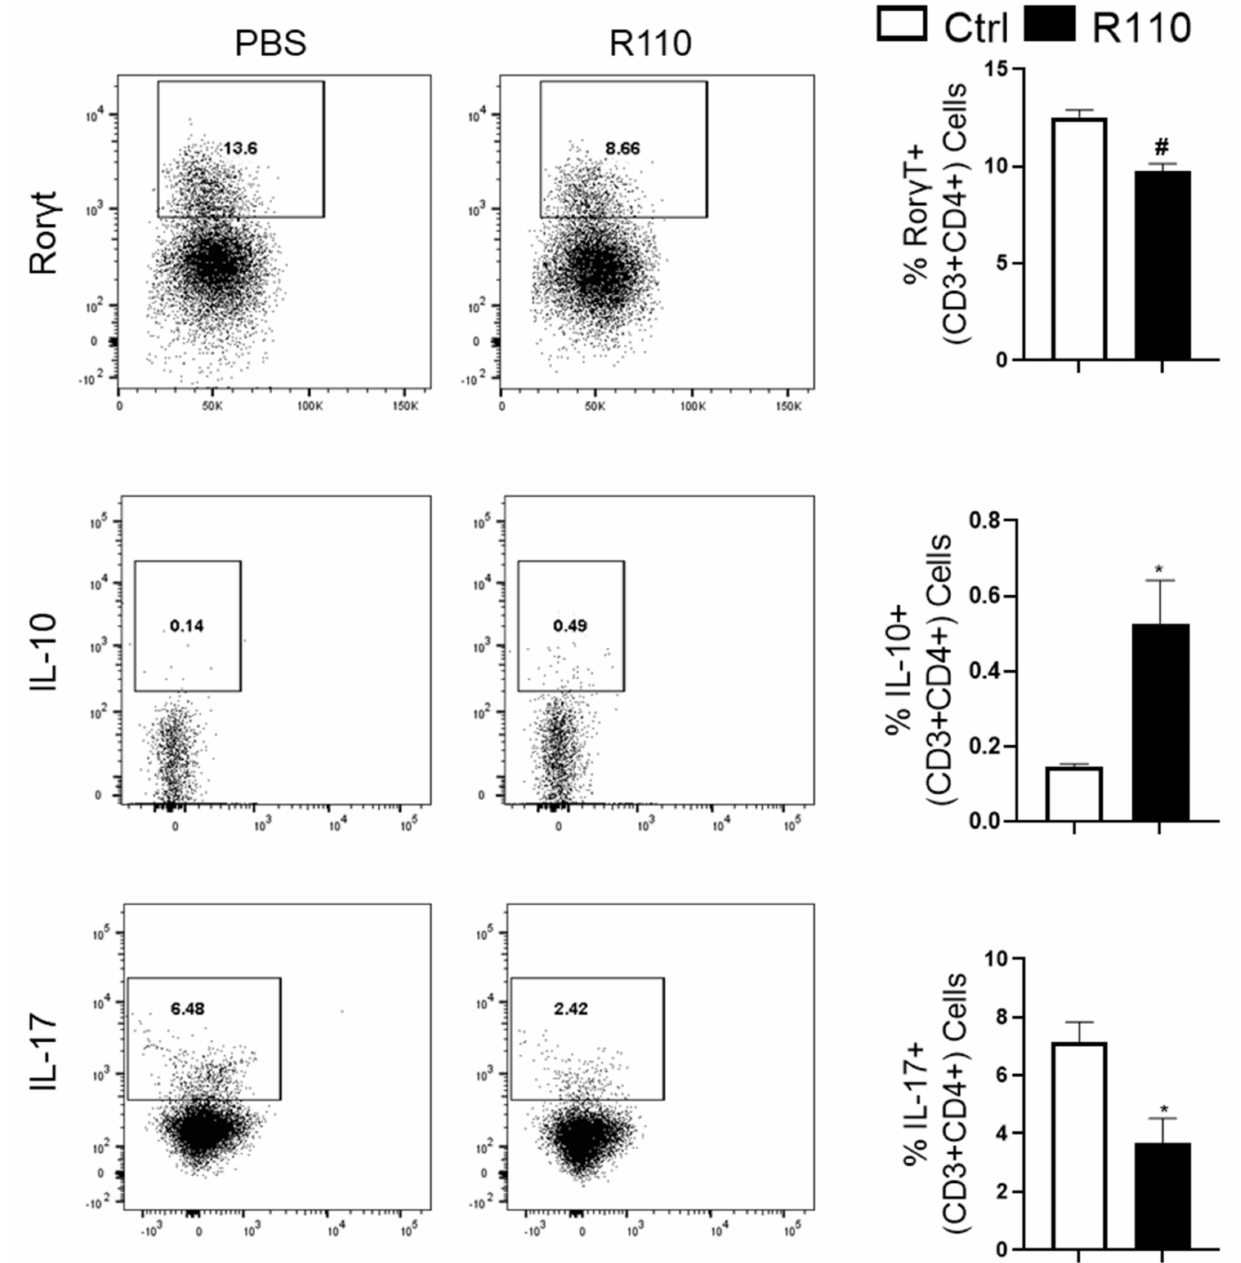
Figure 4. SlpA modulates the T cell response in colitis mice. Colonic cells isolated and stained for CD45, CD3, CD4, Ror γ t, IL-17, and IL-10 from Rag1 − / − mice after 8 weeks post-initiation of colitis and the subsequent feeding of R110. Data are shown as mean ± SEM and are representative of three different experiments; n = 6 mice/group; * p < 0.05; # p <